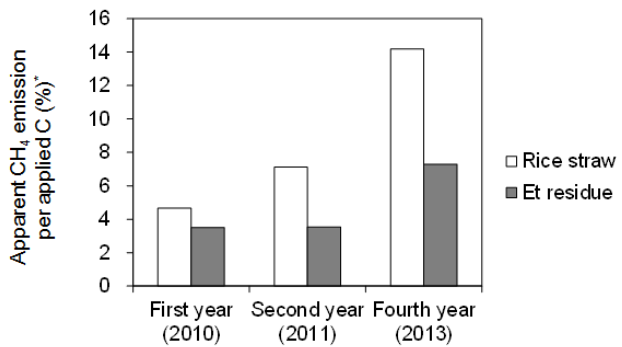
Figure 6. Apparent CH 4 emission factor (CH 4 emission rate derived from organic carbon application) for rice straw and bio ‐ ethanol production residue. * Calculated by the following equation: (each plot’s CH 4 emission—no ‐ application plot’s CH 4 emission)/each plot’s applied C × 100. CH 4 emission—no-application plot’s CH 4 emission)/each plot’s applied C ×